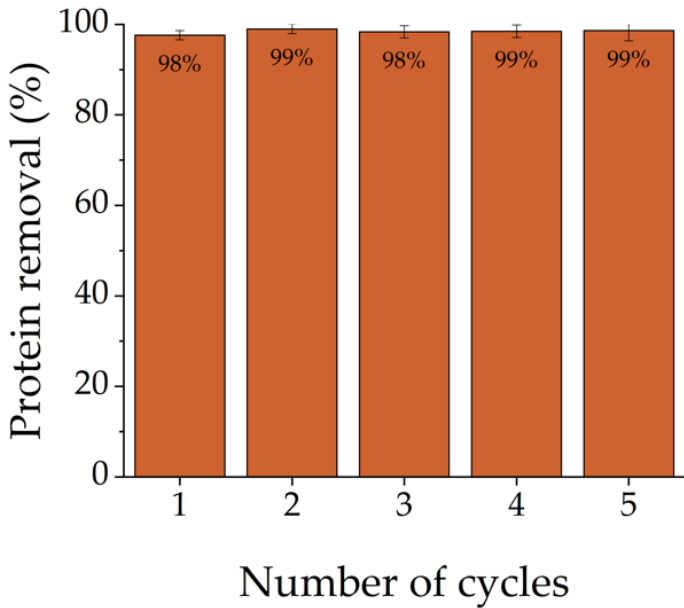
Figure 8. Reusability of DCMC for Cyt C adsorption. Each value is reported as mean ± SD of triplicate independent experiments.